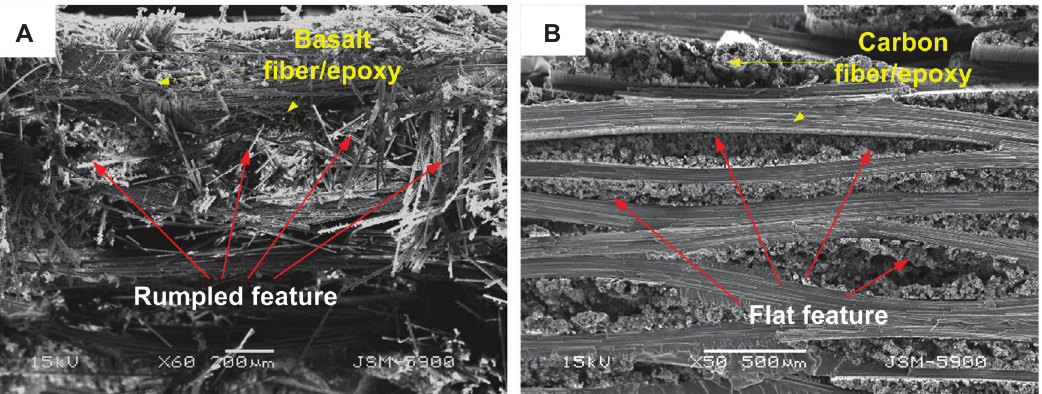
Figure 6 Low- and high-magnification SEM images for the cross section of the fracture surface of the hybrid composites: (A) BFRP and (B)